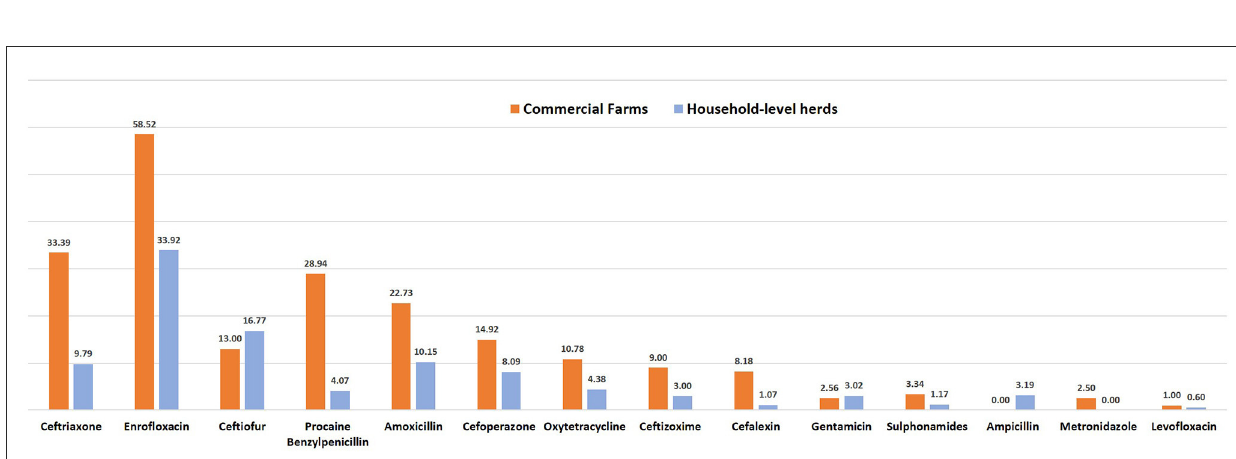
FrontiersinVeterinaryScience